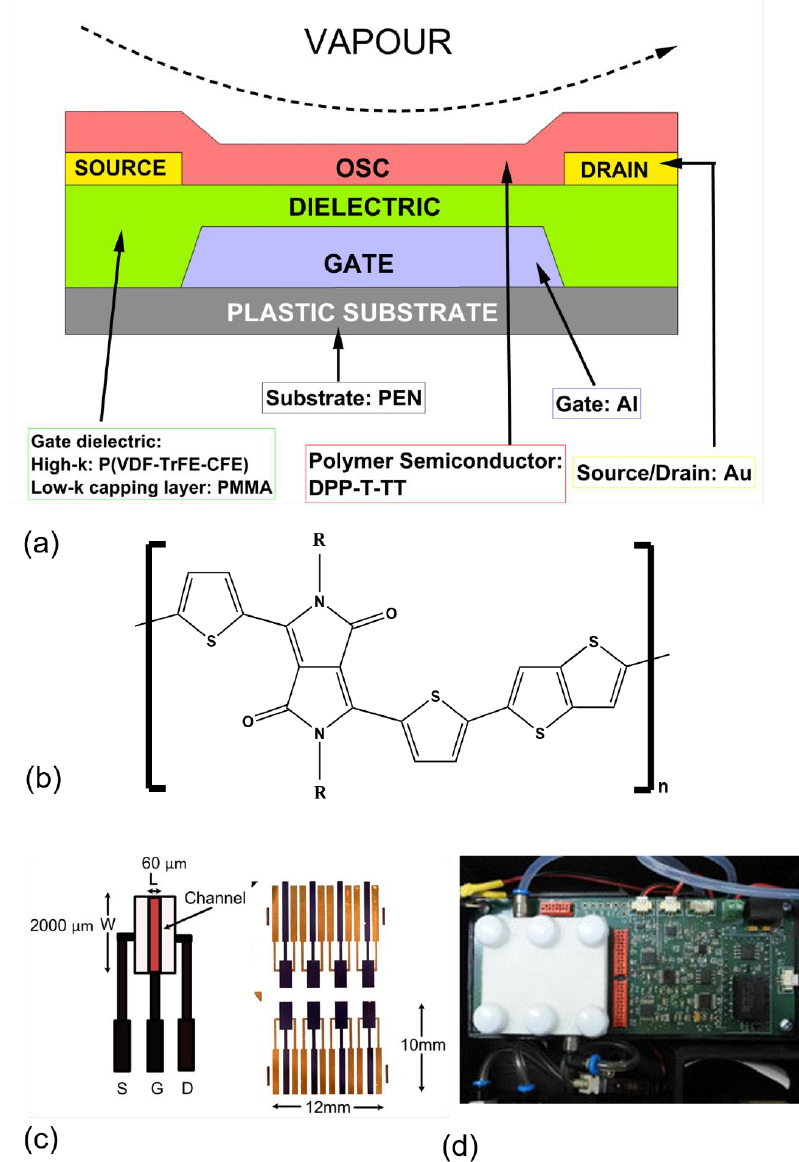
Figure 1. ( a ) Cross section of bottom-gate bottom-contact organic field effect transistors (OFETs) device (BGBC); ( b ) Chemical structure of organic semiconducting polymer (OSC) DPP-T-TT (R = 2-octyldodecyl); ( c ) ( left ) single OFET with connection pads and showing the channel (L = length, W = width), ( right ) array of 8 OFETS fabricated on the polyethylene naphthalate (PEN) substrate ( d ) data acquisition system — the white header covers the OFET array and serves as a gas delivery system.